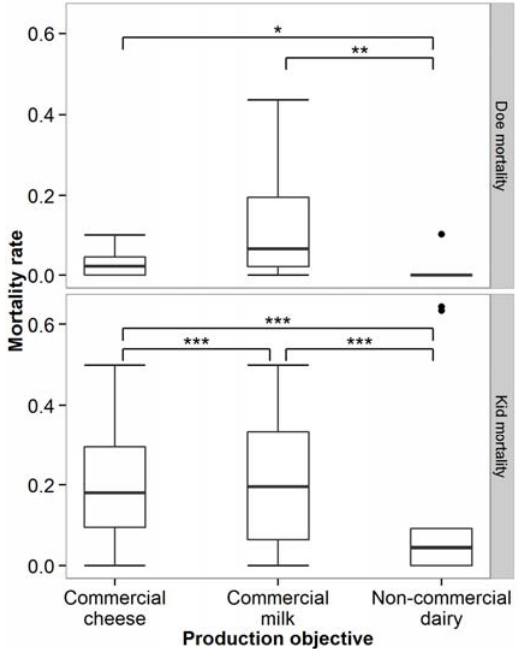
Figure 2. Overall reported doe and kid mortality on goat holdings in northern Morocco based on monthly data collections between September 2009 and August 2012. Holdings were classified by dairy production status: commercial milk, commercial cheese and non-commerical dairy. Asterisks indicate signficant differences after controlling for repeated measures: * p < 0.05, ** p < 0.01, *** p < 0.001.